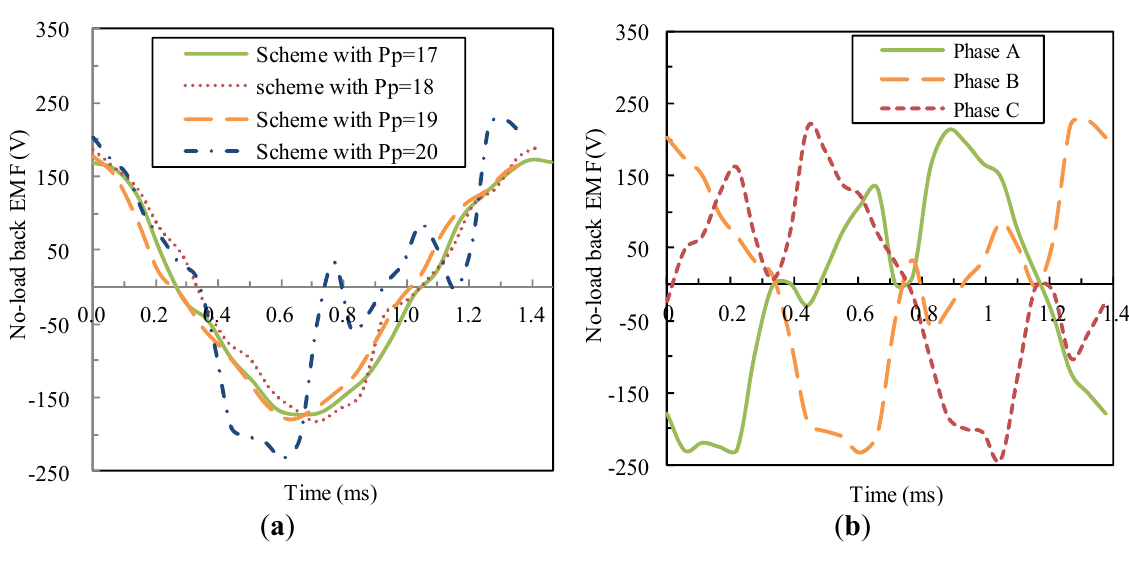
Figure 15. No-load back EMF waveforms: ( a ) one-phase no-load back EMF waveforms for four schemes; and ( b ) three-phase no-load back EMF waveforms for the scheme with p = p